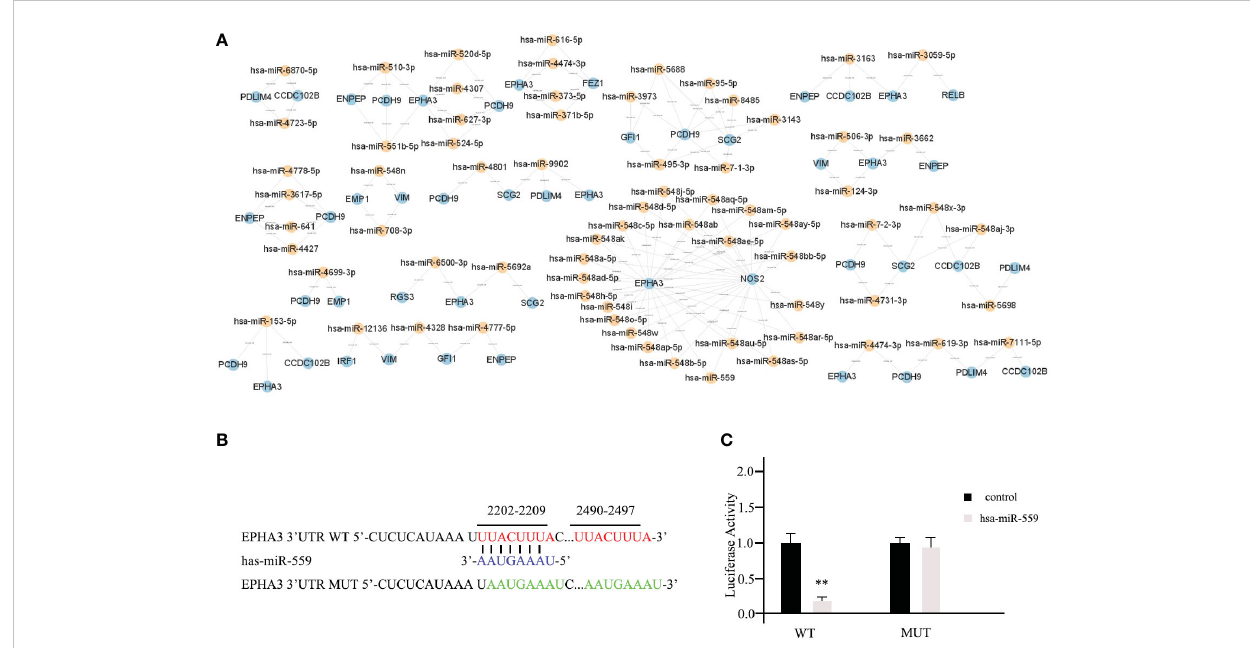
FIGURE 4 PredictionofpotentialmiRNAsforTMEprognosticgeneofbreastcancerprognosis. (A) Theestablishmentofanetworkof15TMEprognosticgenesandtargeting miRNAsusingthemiRNAswithTarGetScorescoresgreaterthan80. (B) Theschematicdepictingthewildtype(WT)andthemutant(MUT)-speci fi cfragmentsof3 ’ UTRofEPHA3. (C)